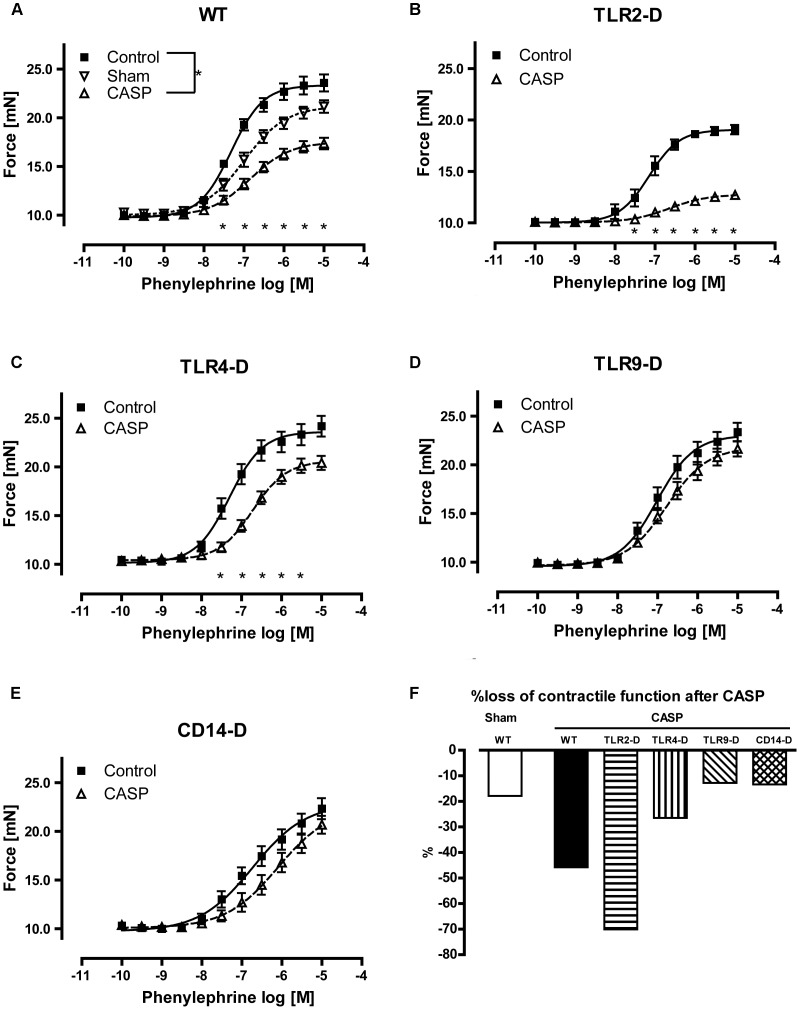
Arterial contractility 18 hours after CASP.
A A significant hypocontractility of aortic rings in CASP- WT animals, but not in sham-operated WT animals was observed at phenylephrine concentrations of 10−7,5 to 10−5M. B TLR2-D mice exhibited a significantly lower maximal contractile response compared to WT animals (TLR2-D 19.07±0.454 mN vs. WT 23.59±0.872 mN; p<0.05). C Significant reduction of vascular contractility following CASP was also observed in TLR4-D mice compared to controls (p<0.05), but it was less severe than in WT animals. D, E CASP did not influence vascular contractility in TLR9-D and CD14-D mice, however CD14-D mice had a significantly higher EC50 of phenylephrine (Table S1). F Standardized maximal loss of vascular contractility. In WT mice sham surgery led to a 17% decrease of vascular contractility, compared to 45% after CASP-treatment. TLR2-D animals lost 70% of their maximum contractile response, whereas CASP-treated TLR4-D mice lost only 27% and CD14-D as well as TLR9-D mice were insensitive to CASP (*p<0.05; n≥5 animals in each group; mean ± SEM).